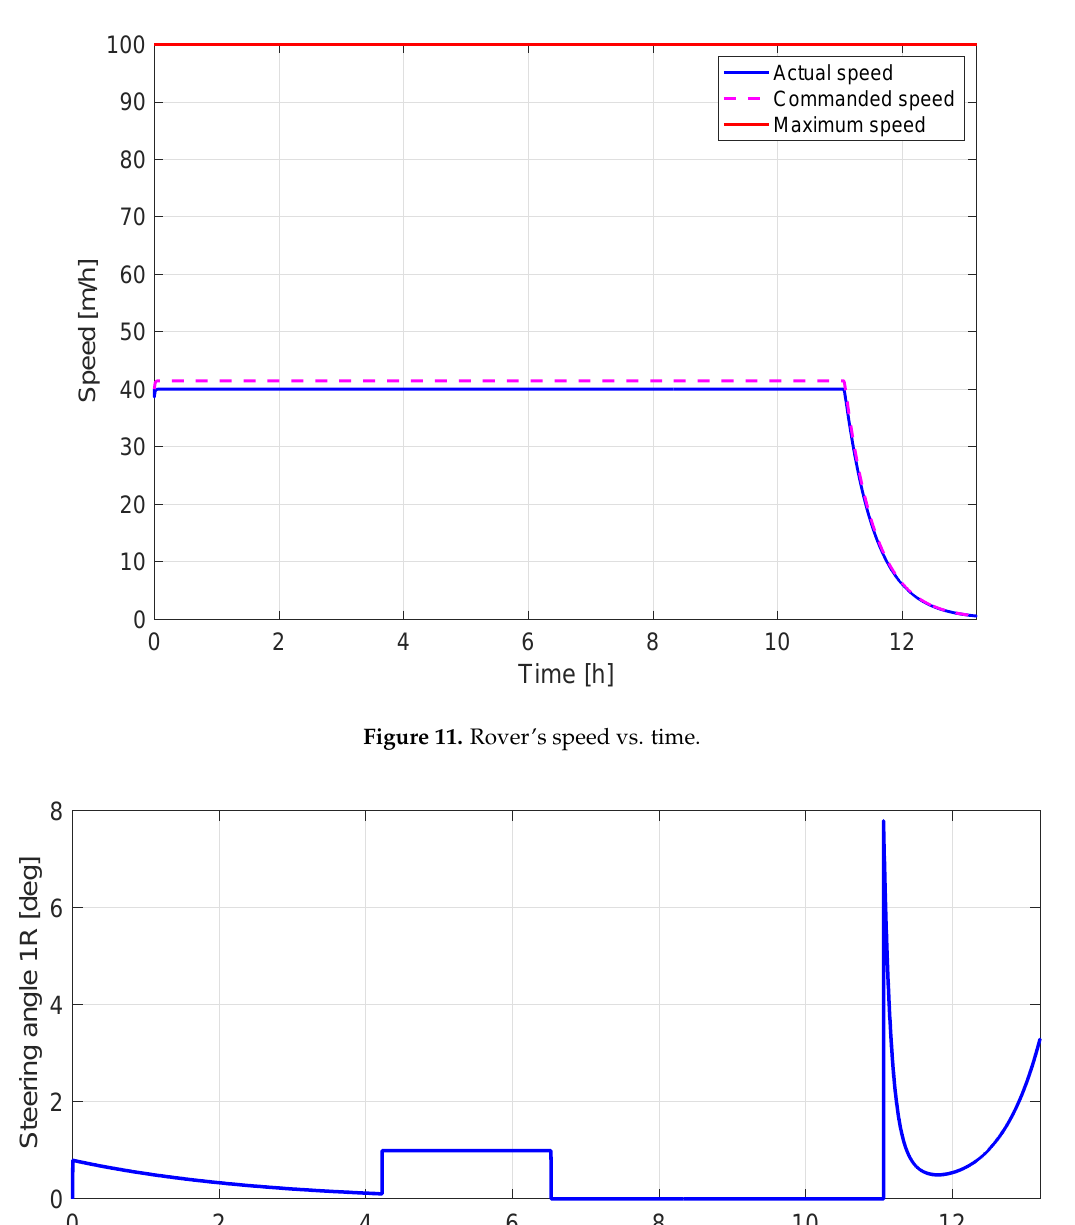
Figure 10. Simulated rover’s trajectory vs . shortest path. The initial coordinates of the rover and the final target are marked in red and green, respectively. The obstacles are marked in black.